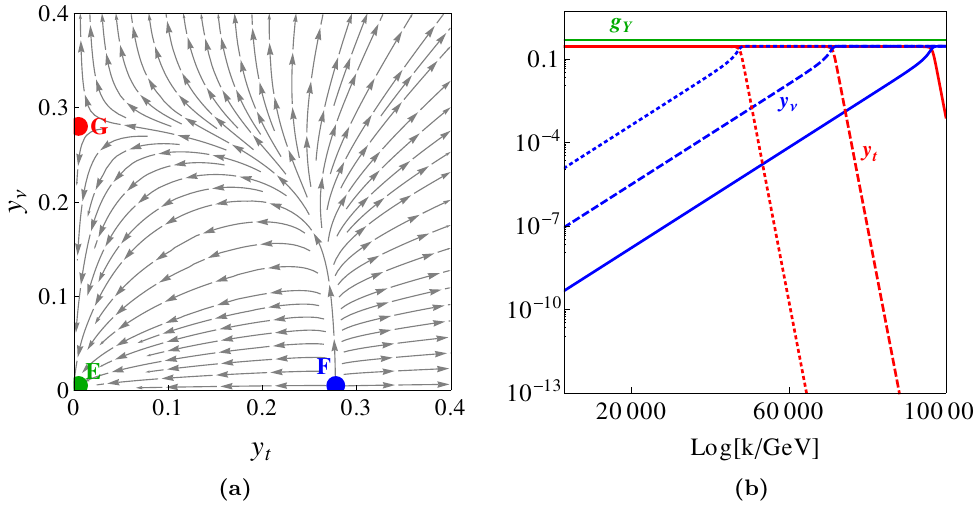
Figure 3. (a) Phase diagram in the plane ( y t , y ν ) for the three fixed points featuring g ∗ 6 = 0 in Y table 2. The RG flow directions point towards the UV. (b) The flow of the top (red) and neutrino (blue) Yukawa coupling for three different choices (solid, dashed, dotted) of the y trajectory joining t the UV fixed point FP to the IR fixed point FP . The abelian gauge coupling is shown in solid G F green. In both panels the AS gravity parameters are set to f = 0 . 0096 and f = 0 . 0002 g y